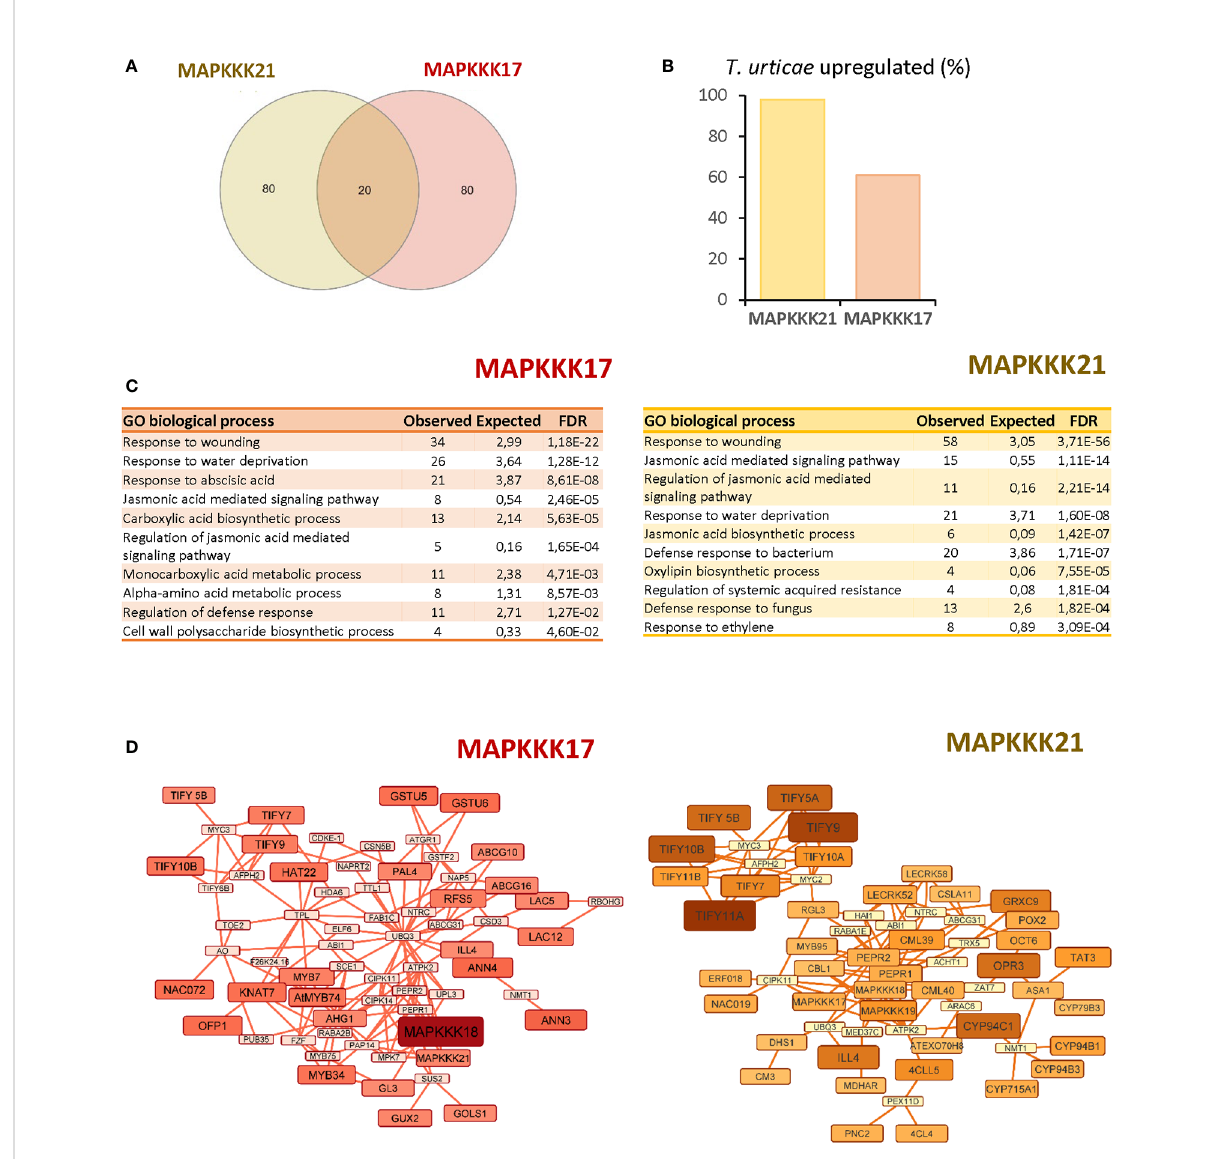
FIGURE 4 Comparison of the 100 most correlated genes to MAPKKK17 and MAPKKK21 . (A) Venn diagram showing the numbers of shared and speci fi c genes correlated to MAPKKK17 and MAPKKK21 . (B) Percentage of the genes that were identi fi ed as differentially expressed in the RNA-seq analysis after mite infestation. (C) Lists of the 10 most signi fi cantly enriched biological processes for each correlated list of genes. (D) Networks connecting the most correlated genes to MAPKKK17 and MAPKKK21 . Larger node sizes and darker colors identi fi ed the genes with the highest correlation coef fi